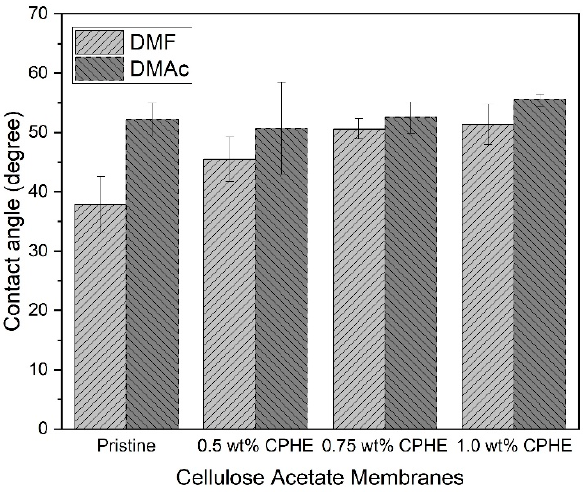
Figure 5 . Hydrophilicity of the cellulose acetate membrane sheets. Figure 5. Hydrophilicity of the cellulose acetate membrane